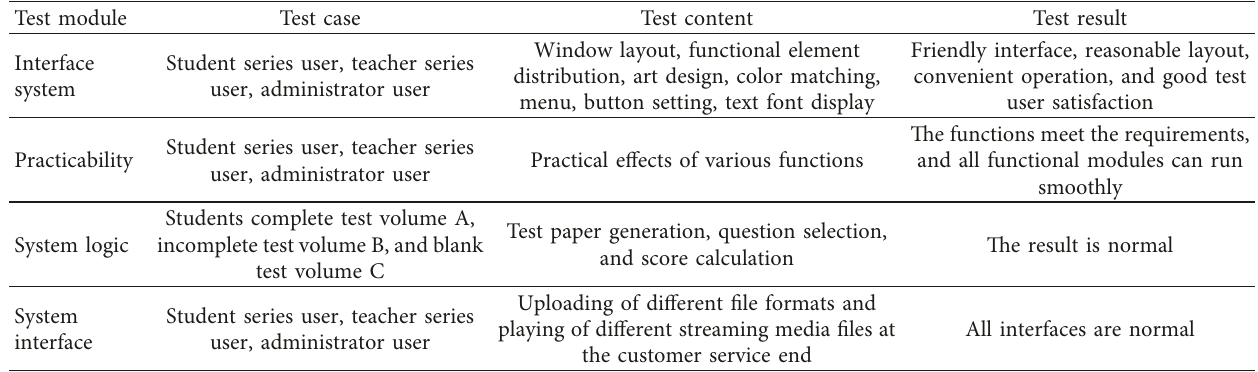
Table 3: Function test.